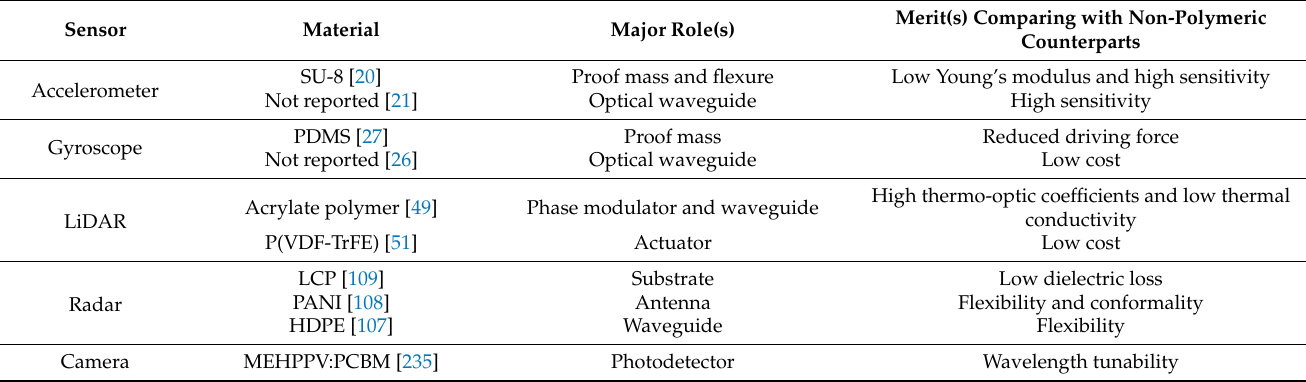
Table 5. Summary of representative applications of polymers in sensors for odometry.